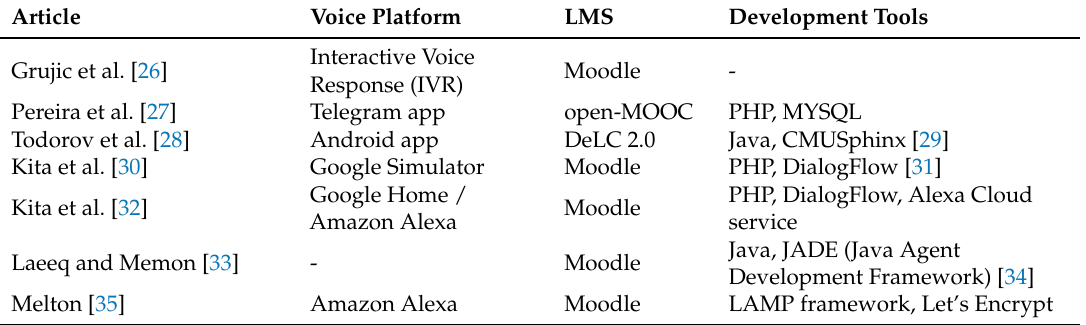
Table 1. Comparison of